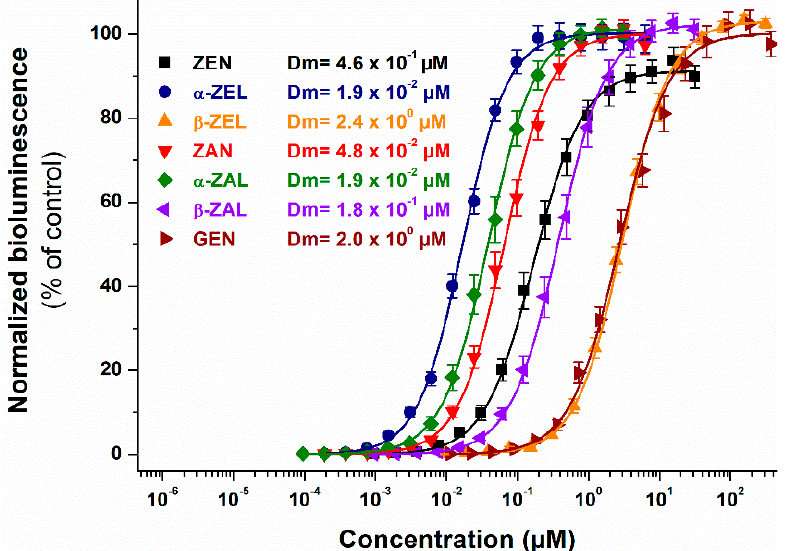
Figure 4. Estrogenic effects of ZEN, α -ZEL, β -ZEL, ZAN, α -ZAL, β -ZAL, and GEN based on the BLYES ( Saccharomyces cerevisiae ) assay. Statistically significant ( p < 0.01) estrogenic effects were observed at (and above) the following mycotoxin concentrations: 3.1 × 10 − 2 µM for ZEN, 1.5 × 10 − 3 µM for α -ZEL, 3.1 × 10 − 1 µM for β -ZEL, 1.2 × 10 − 2 µM for ZAN, 2.4 × 10 − 2 µM for α -ZAL, 3.0 × 10 − 2 µM for β -ZAL, and 7.2 × 10 − 1 µM for GEN.